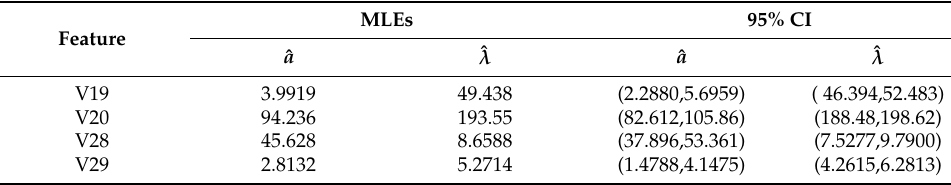
Table 3. MLEs and 95% CIs of the MPoE parameters.